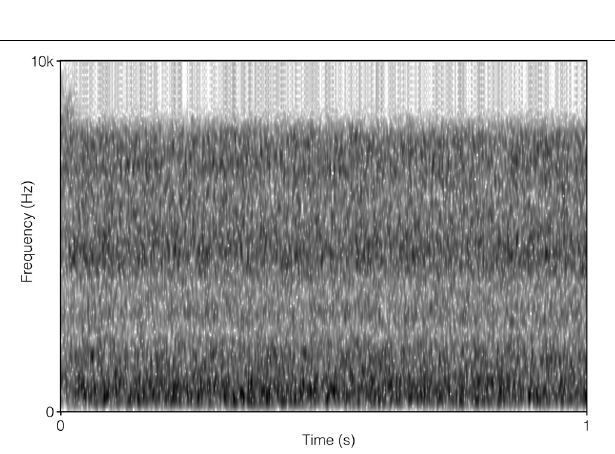
FIGURE 1 | The long-term average spectrum for the two auditory distracters.